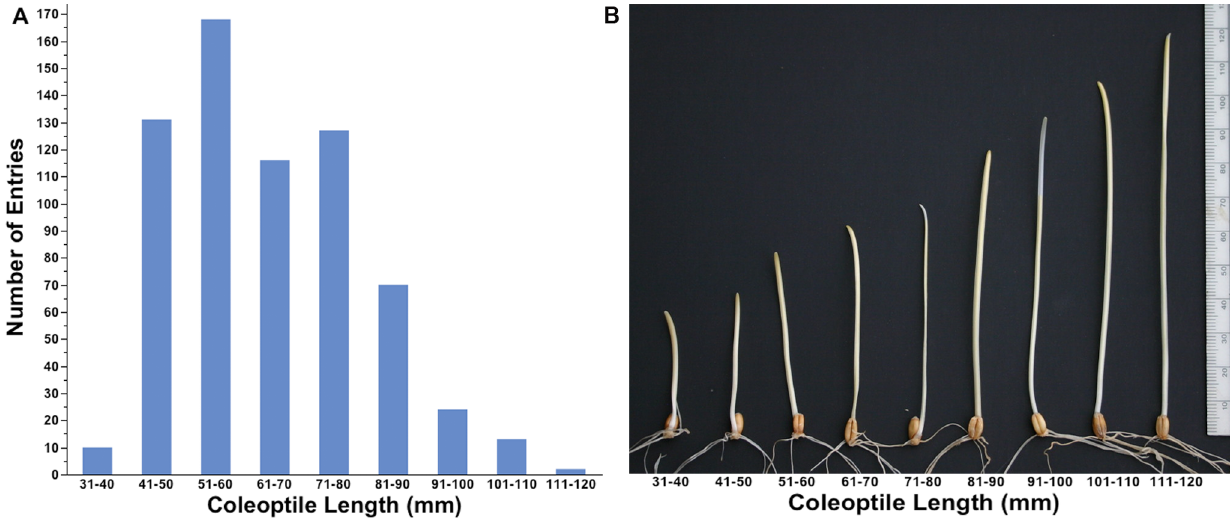
Figure 1. Coleoptile length distribution among 662 entries of the world wheat collection in 10-mm intervals (A). Representative picture of coleoptiles in each 10-mm increment class interval (B).